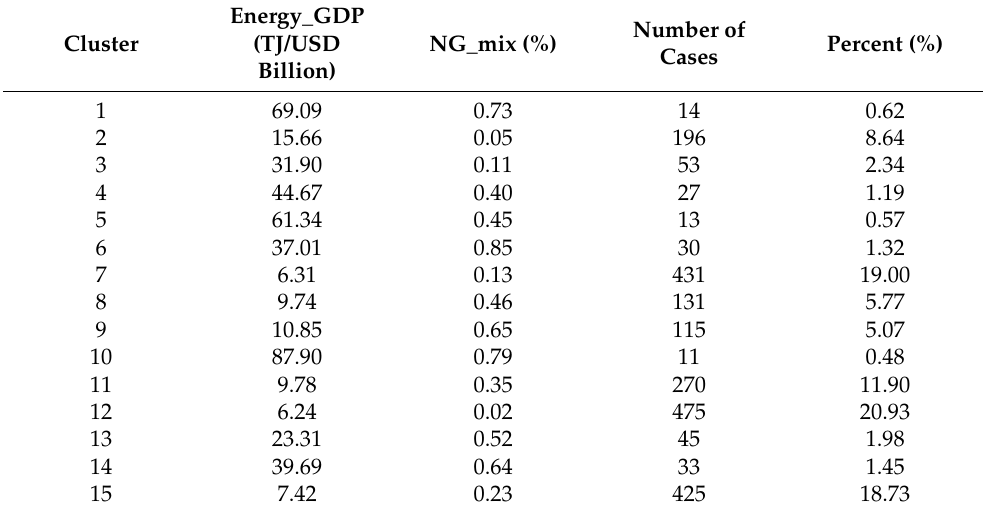
Table 4. Characteristics of 15 clusters obtained by the k-means